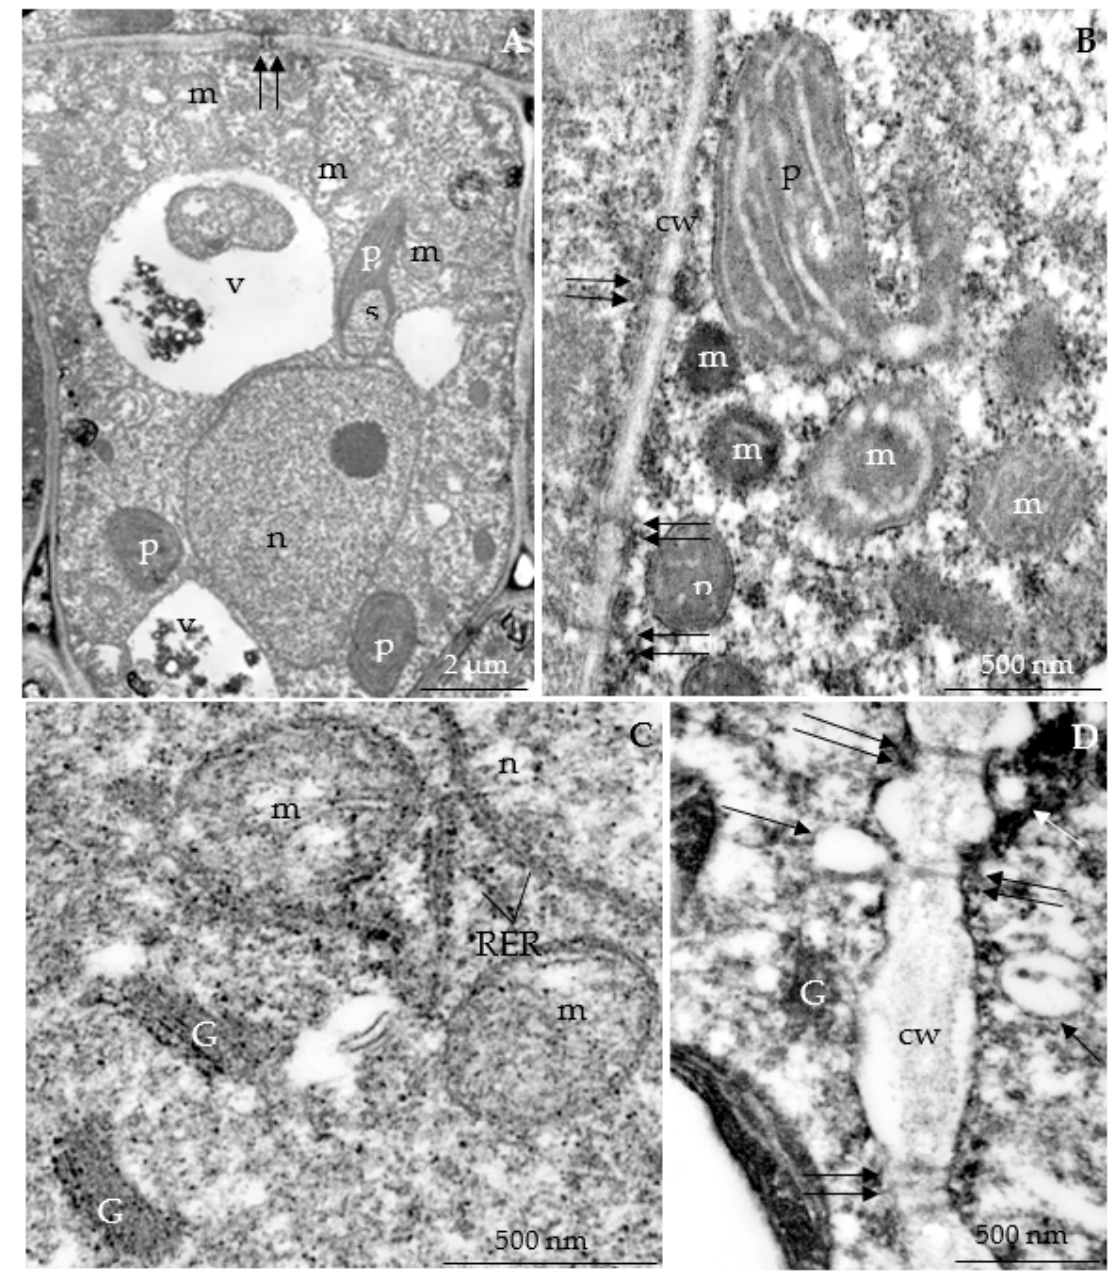
Figure 20. ( A – D ). Fragments of nectary epidermis ( B , D ) and parenchyma ( A , C ) cells in R. idaeus ‘Polana’ in the full secretion phase. ( A ): pleomorphic plastids (p), vacuoles (v) with flocculent sediment in the cell sap, mitochondria (m), plasmodesma (two arrows). ( B , D ): plasmodesmata (two arrows) in the cell wall, transport vesicles (arrow), plastid (p) with a reduced thylakoid system and mitochondria (m) (micrograph B), amyloplast with starch grains (s) (micrograph D). ( C ): Golgi apparatus (G) near the cell nucleus (n), mitochondria (m), rough endoplasmic reticulum (RER).